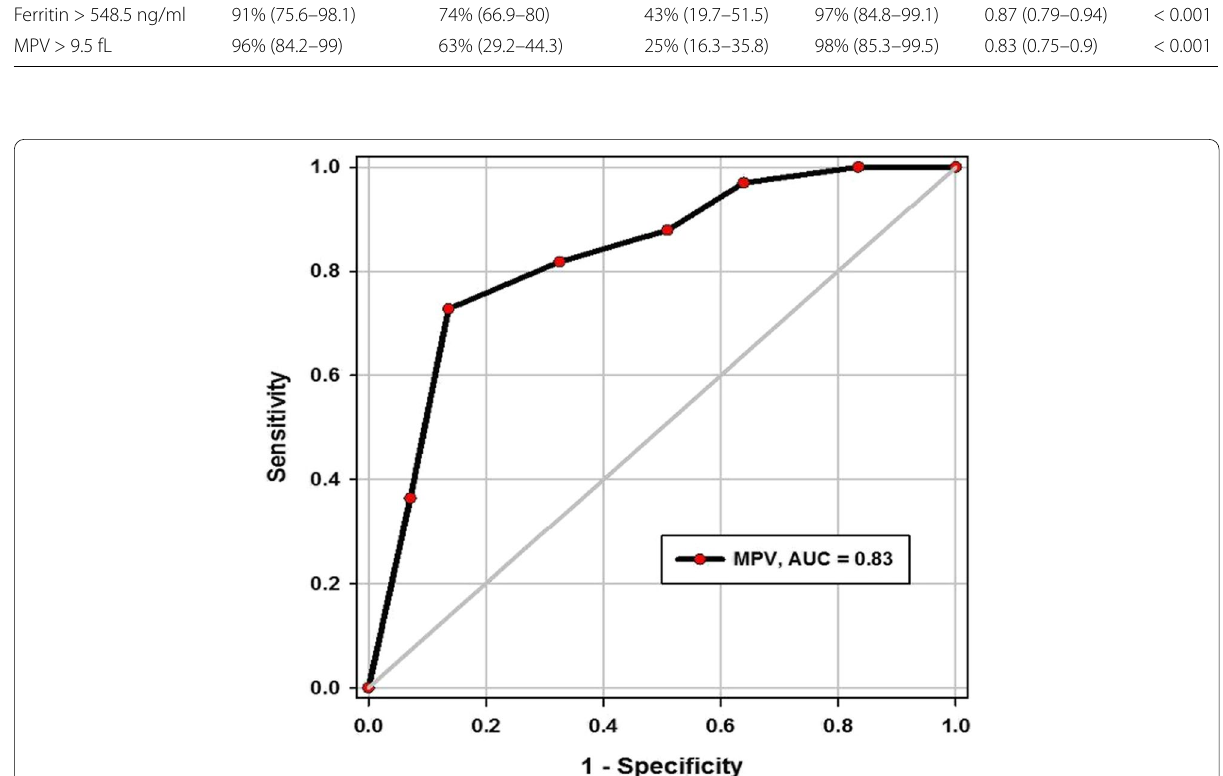
Fig. 2 Receiver operating characteristic (ROC) curve for MPV in predicting severity of